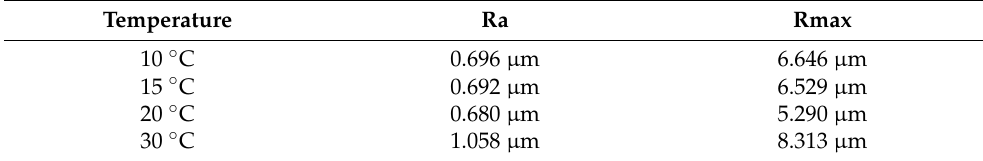
Figure 9. SEM characterization of surface morphology with different temperature, ( A ) is 10 °C, ( B ) is 15 °C, ( C ) is 20 °C and ( D ) is 30 °C. Table 7. Ra and Rmax values with different